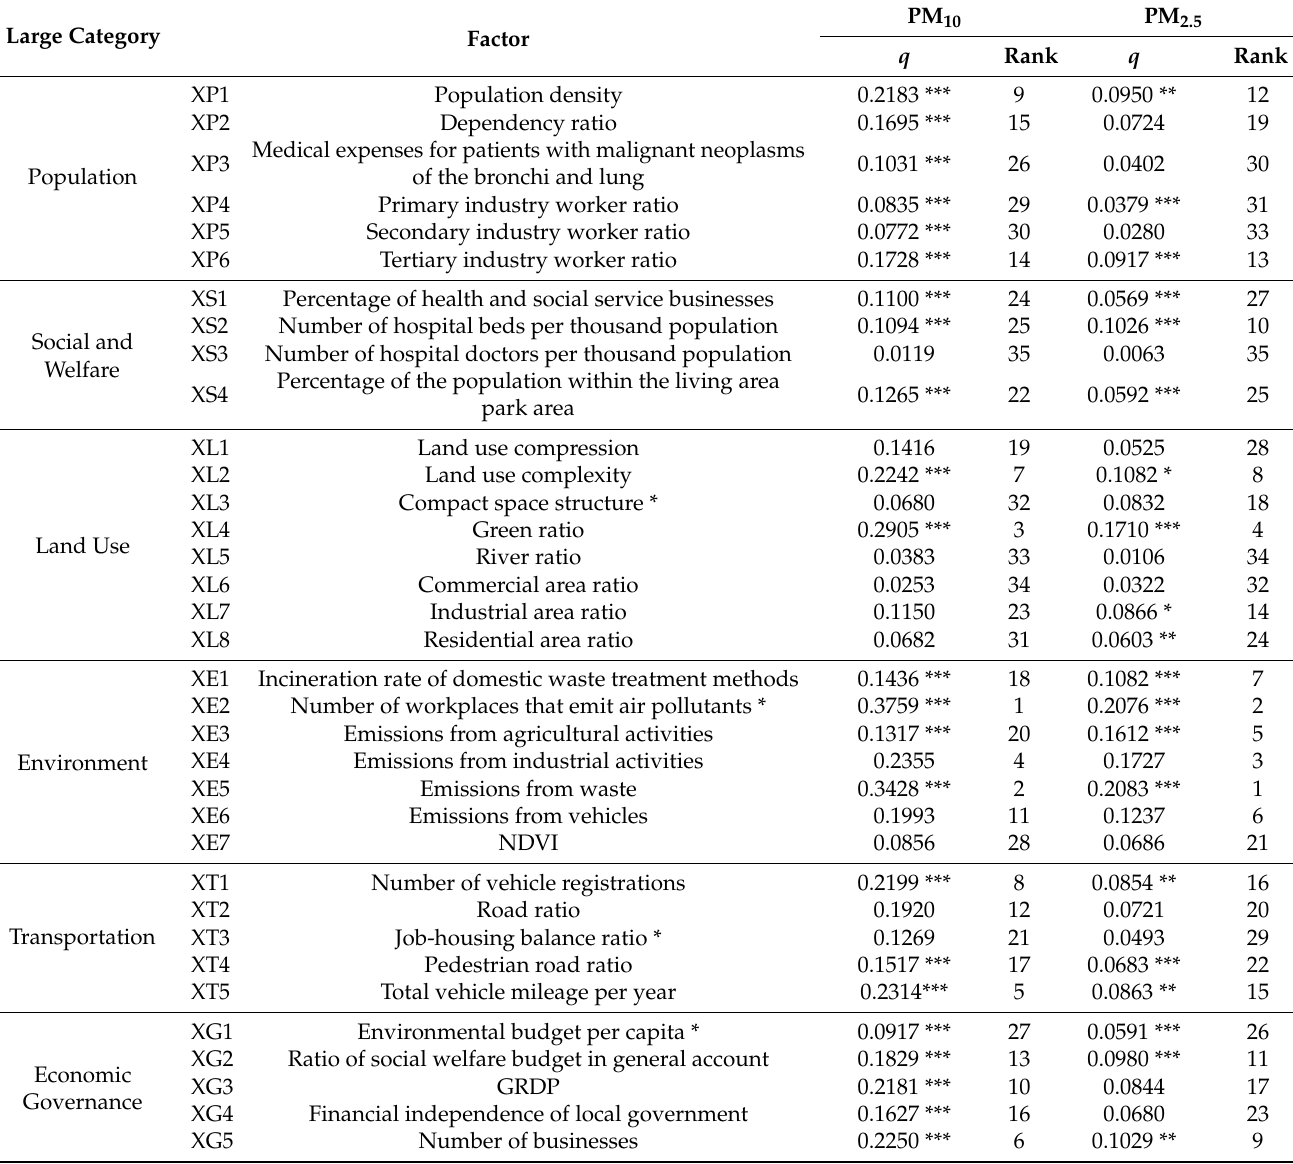
Table 3. The results of factor detection for the influencing factors of urban PM 10 and PM 2.5 in